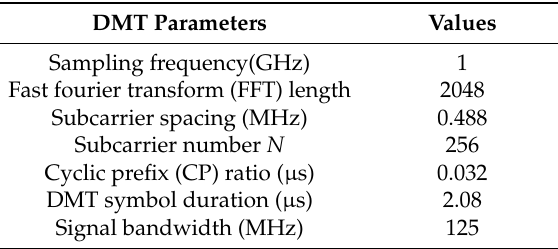
Figure 7. DMT modem with bit ‐ loading scheme. Table 1. The modulation parameters.